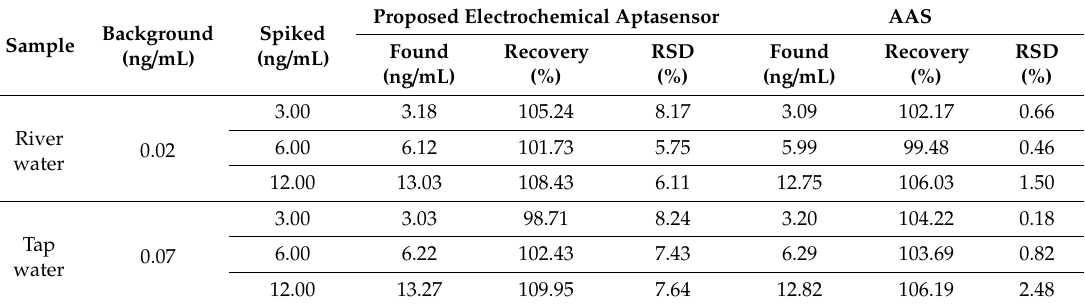
Table 2. Determination of Cd 2 + in environmental samples (n = 3).